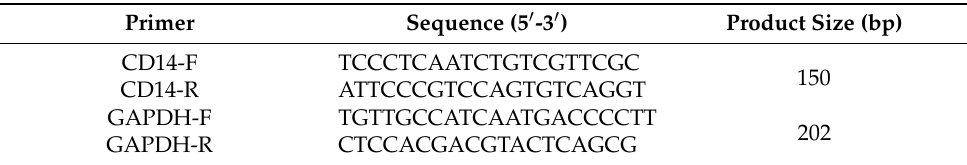
Table 2. Sequences of the